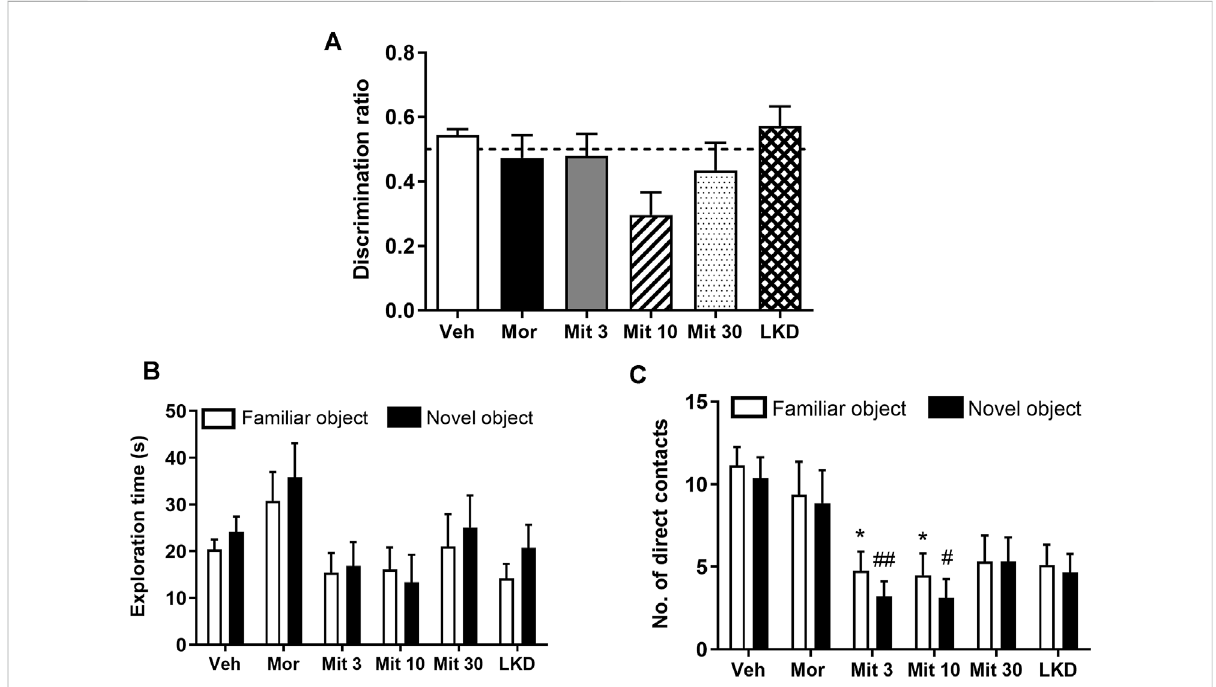
FIGURE 2 Effects of adolescent kratom exposure on (A) Discrimination ratio after 1-h retention interval (B) Exploration time on both familiar and novel objects, and (C) Number of direct contacts with both familiar and novel objects. Data are expressedas mean ± SEM ( n = 8 – 10). * p < 0.05, vs. familiar object of the vehicle-treated group. # p < 0.05, ## p < 0.01, vs. novel object of the vehicle-treated